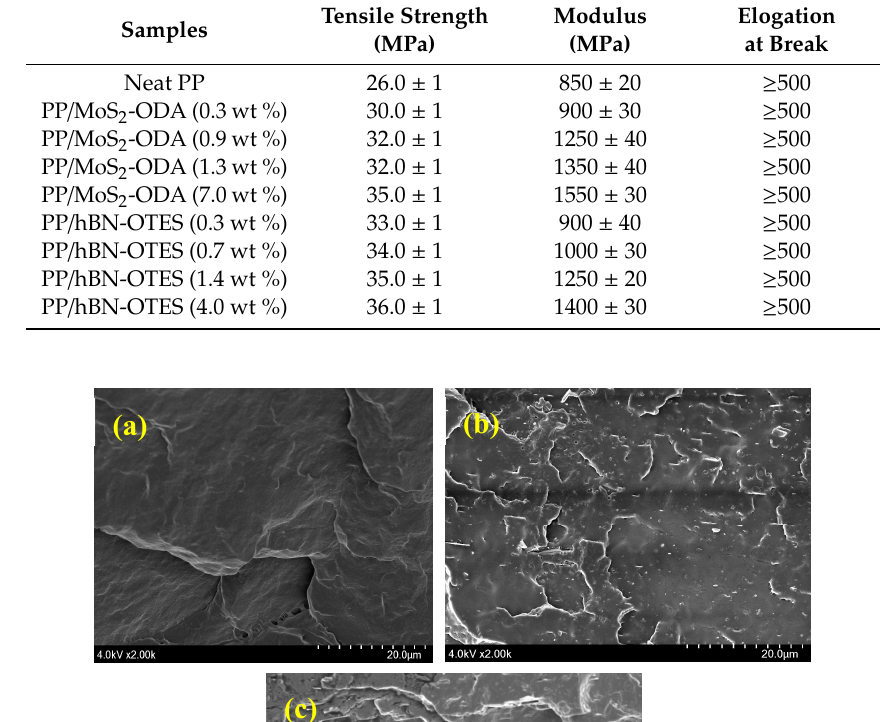
of 2D-nanosheet.